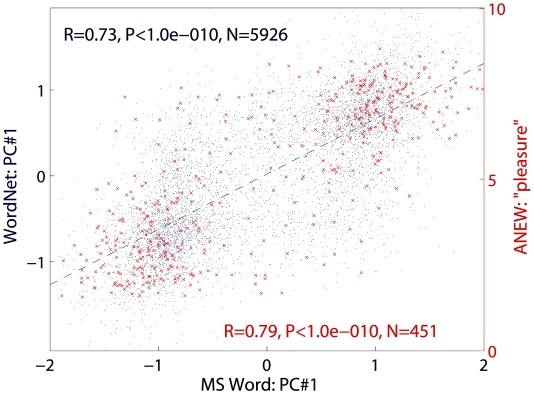
Semantic map correspondence across languages and methodologies.The scatter plots demonstrate numerical correspondence between MS English PC1 and both WN English PC1 (blue) and the first ANEW dimension, ‘pleasure’ (red). The dashed line represents the common linear fit. Captions show correlation coefficients (R), corresponding P-values, and numbers N of common words used for the analysis. All three distributions (MS English PC1, WN English PC1, and ANEW pleasure) are clearly bimodal. The correlations are highly significant even when analyzed for the two separate clusters of data. For words with negative MS English PC1 values, the correlation with the corresponding WN English PC1 values is R = 0.46 (p<10−10, N = 3101); and with ANEW: R = 0.36 (p<10−7, N = 226). For the positive MS English values, R = 0.40 for WN English (p<10−10, N = 2825) and R = 0.39 for ANEW (p<10−8, N = 225).